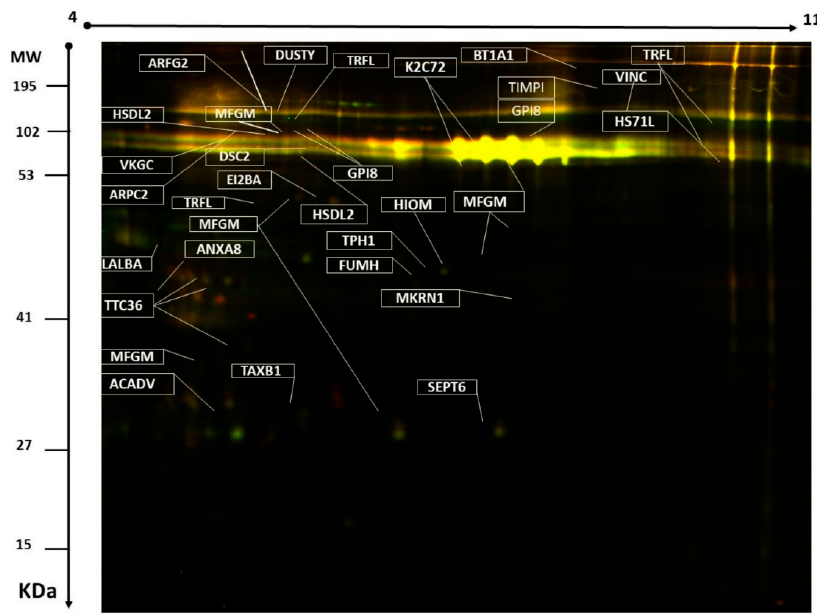
Figure 2. Representative image of the protein spots from milk samples showing the statistically significant di ff erentially expressed spots (ANOVA p ≤ 0.05 and fold change ≥ 1.5, 44 proteins) successfully identified with MALDI-TOF / TOF and labeled with MASCOT